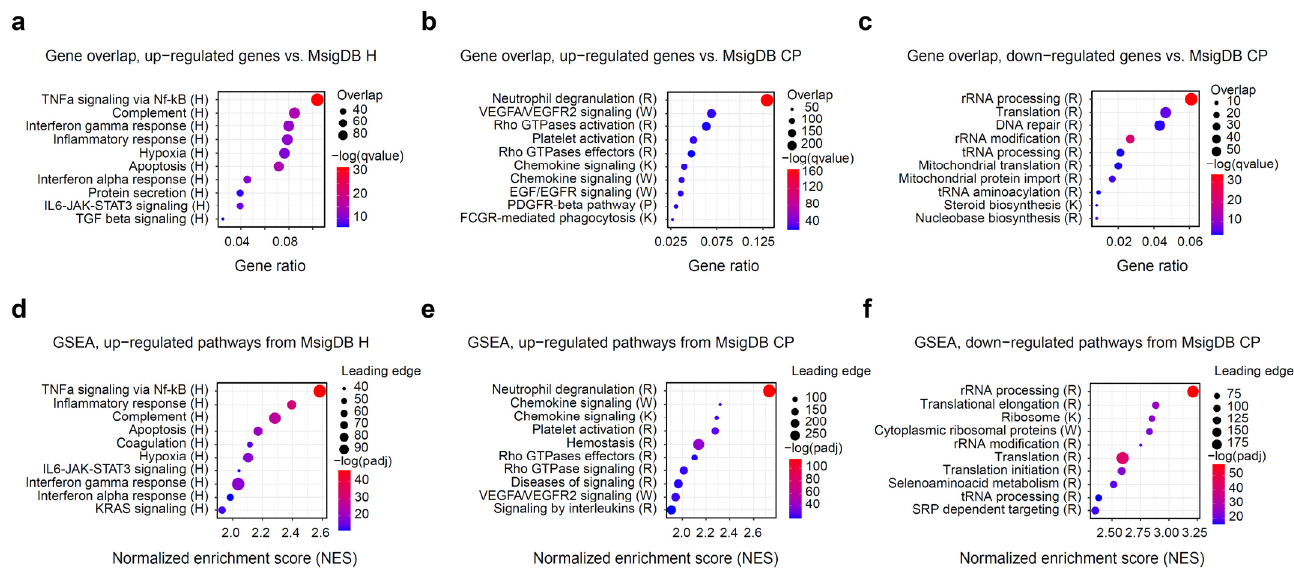
Figure 2. Gene overrepresentation and gene set enrichment (GSEA) analysis of the differentially expressed genes. Molecular signature database (MsigDB) H and CP collections were used to func- tionally characterize expression changes. Letter following the pathway name denotes its source: R, Reactome; K, KEGG; W, WikiPathways. ( a – c ) Top 10 significantly up- and down-regulated pathways, according to Fisher’s exact test, calculated with clusterProfiler. Down-regulated hallmark pathways only included one significant gene set (HALLMARK MYC TARGETS V2), and were omitted from the plot. ( d – f ) Top 10 significantly up- and down-regulated pathways according to GSEA, calculated with fGSEA. Down-regulated hallmark pathways only included one significant gene set (HALLMARK MYC TARGETS V2) and were omitted from the plot. Gene overlap indicates the number of genes in the leading edge.